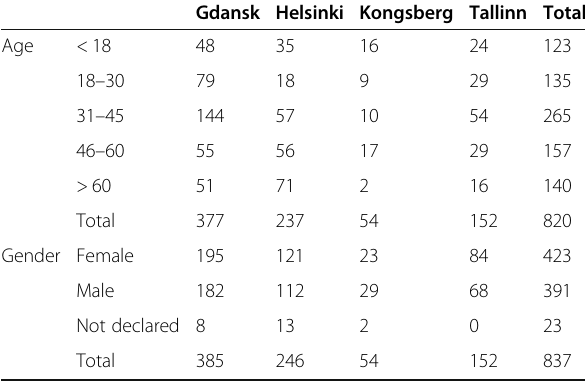
Table 3 Distribution of responses by age and gender per